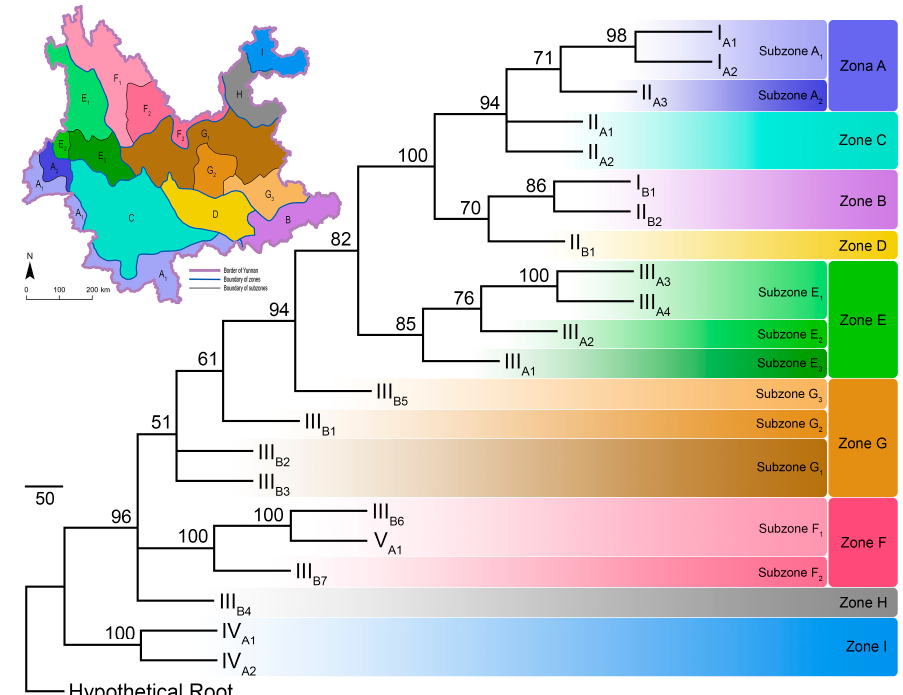
Figure 4. The maximal parsimony tree built from the parsimony analysis of endemicity (PAE), hypothetical root represents the artificially created ecoregion without any pollinating